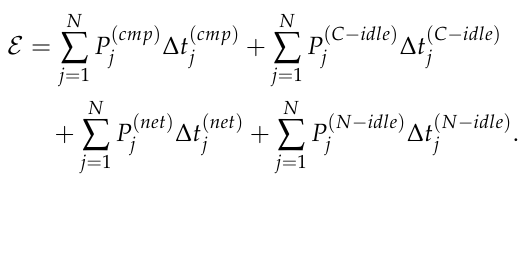
= W T is the k -th tied k k